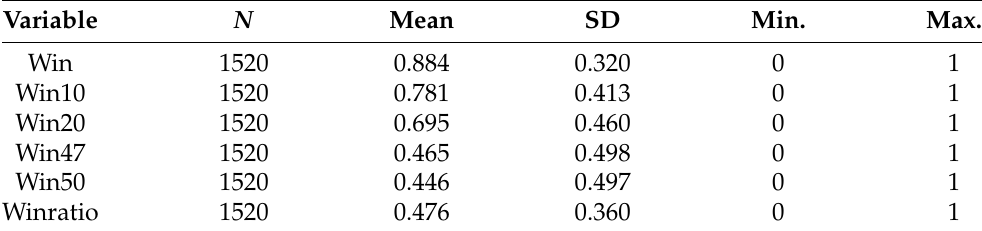
Table 3. Descriptive statistics of the dependent variables.